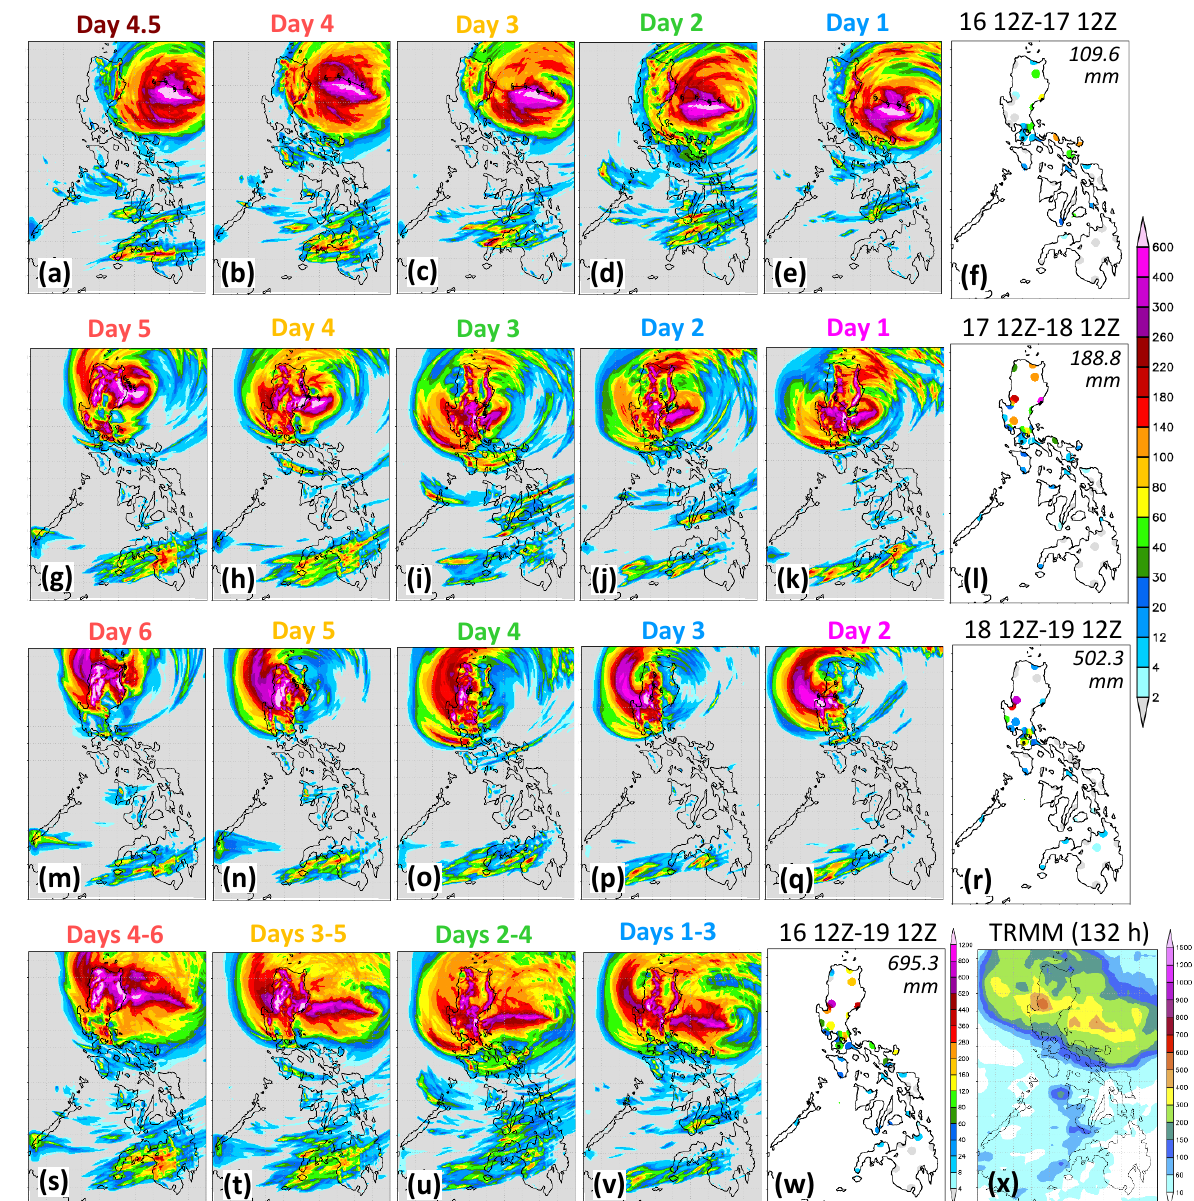
Figure 8. As in Figures 4a-f, except for predictions (ranges as labeled) and gauge observations for the 24 h rainfall distributions over ( a – f ) 1200 UTC 16-1200 UTC 17 October, ( g – l ) 1200 UTC 17-1200 UTC 18 October, and ( m – r ) 1200 UTC 18-1200 UTC 19 October 2015 during TY Koppu (2015), respectively. ( s – x ) As in ( a – f ), except at ( s – v ) four different ranges and ( w ) from the gauge data for 72 h QPFs over 1200 UTC 16 – 1200 UTC 19 October. ( x ) TRMM total rainfall (mm) for the entire typhoon event (132 h starting from 1800 UTC 15 October). The same color scale is used for ( a – r ) and doubled for ( s – v ). Only ( x ) has its own scale.